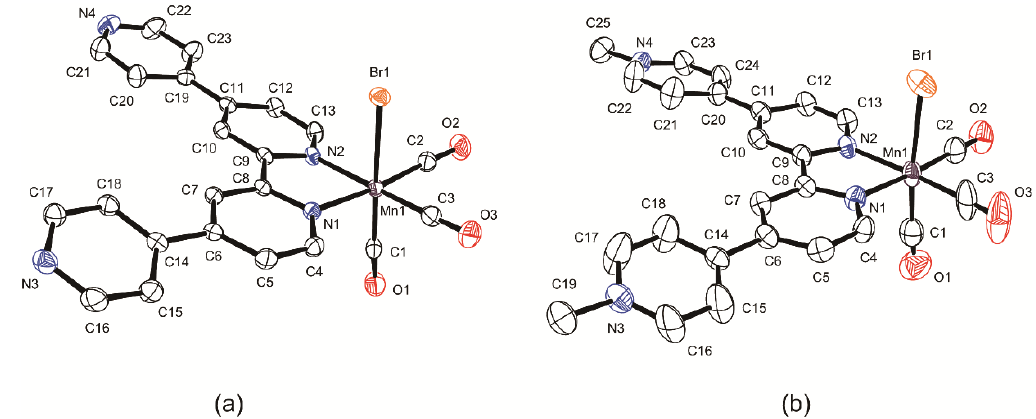
Figure 5. Molecular structures with atom labels and displacement ellipsoids for non-H atoms drawn at the 50% probability level. Counter-anions and H atoms are omitted for clarity. ( a ) fac -[MnBr(CO) 3 (qpy)] and ( b ) fac -[MnBr(CO) 3 (dmqpy)] 2 +